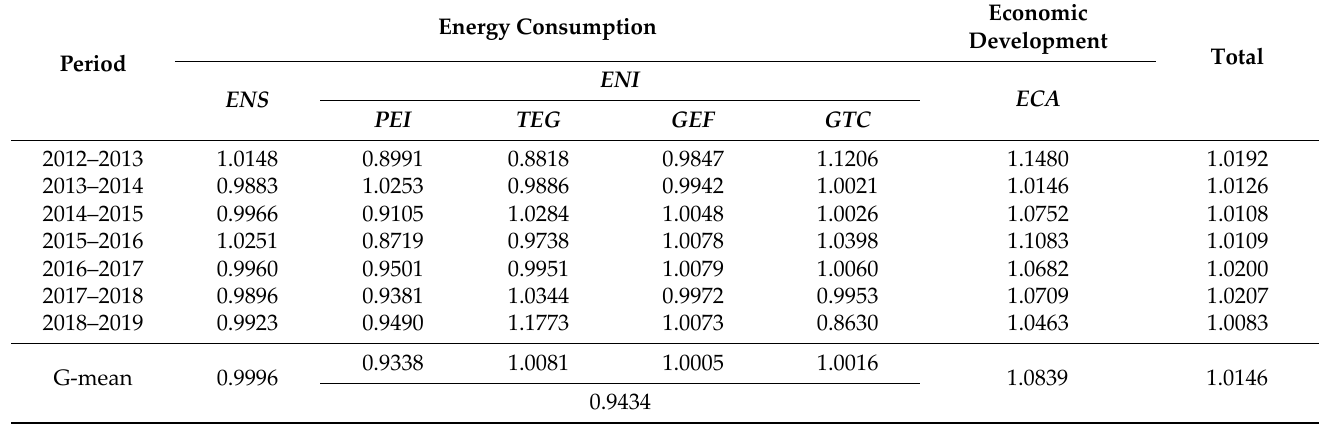
Table 3. Changes in sample countries’ carbon emissions and its decomposition, 2012–2019.